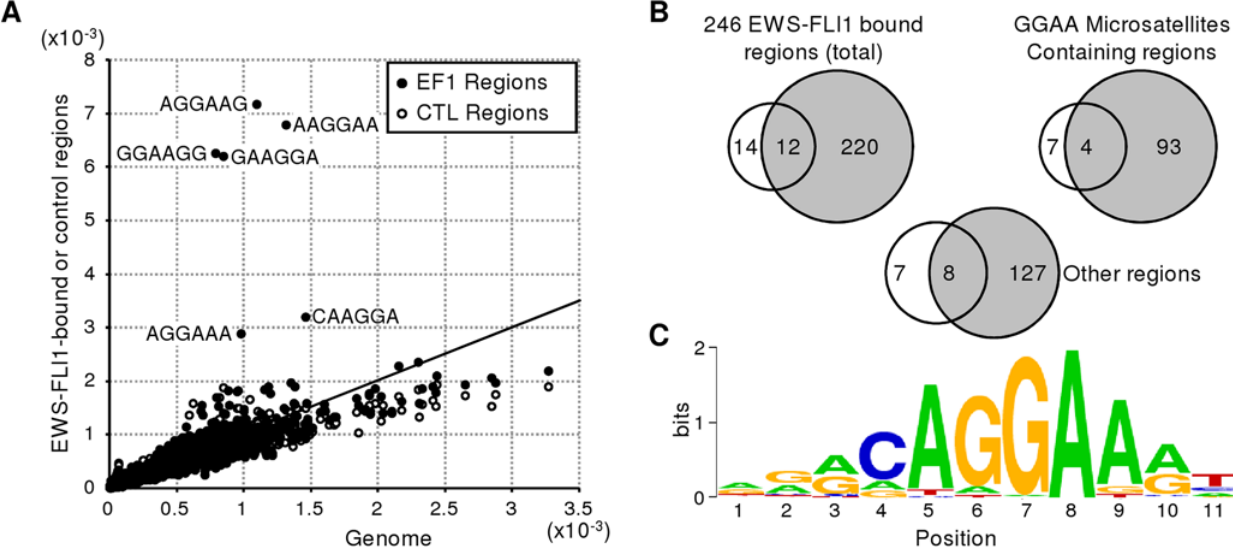
Figure 1. EWS-FLI1 binds GGAA microsatellites or GGAA-rich sequences. A. Enrichment of GGAA motifs in EWS-FLI1-bound sequences. Frequencies of each of 4096 possible 6mer nucleotides found for the 246 identified EWS-FLI1 specific regions (black circle) and for regions identified in the control experiment (white circle) are represented along the Y axis whereas frequency of the same 6mers in the genome is represented on the X axis. B. GGAA repeat enrichment is a common feature of Ewing cell lines. Number of sequences found in A673 (grey circle) and SK-N-MC (white circle) for each type of binding site. C. Consensus motif assessed with MEME algorithm (E-value=4.1 6 10 2 46 ) in regions other than GGAA microsatellites.